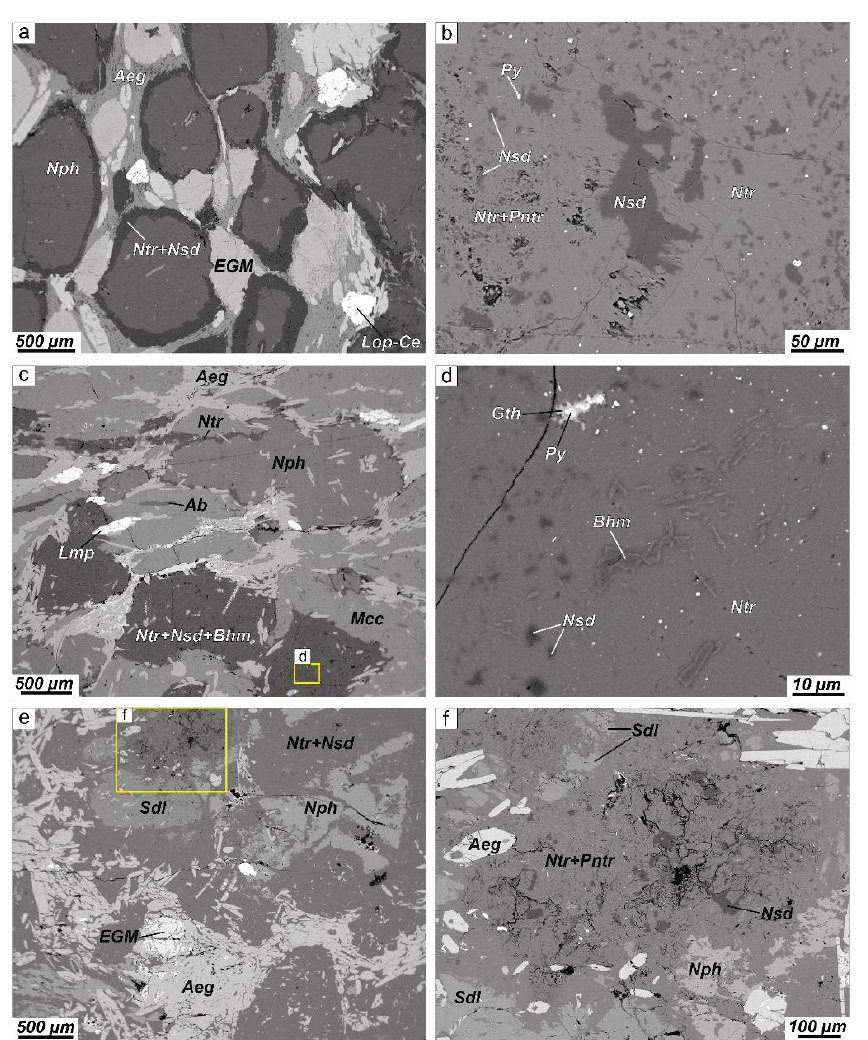
Figure 6. Secondary alteration of nepheline and sodalite in rocks from the Eudialyte and Poikilitic complexes. ( a ) Replacement of nepheline with natrolite and nordstrandite in eudialyte lujavrite from the Eudialyte complex; ( b ) nepheline alteration products in eudialyte lujavrite from the Eudialyte complex; sample LV-350/1; ( c ) pseudomorphs of natrolite + nordstrandite + böhmite after nepheline in lujavrite from the Eudialyte complex; ( d ) nepheline alteration products in lujavrite from the Eudialyte complex; sample LV-377/2; ( e ) replacement of nepheline and sodalite by an assemblage of secondary minerals including natrolite, paranatrolite, and nordstrandite in poikilitic sodalite syenite from the Poikilitic complex; ( f ) nepheline alteration products in poikilitic sodalite syenite from the Poikilitic complex; sample LV-356/3. BSE-images.